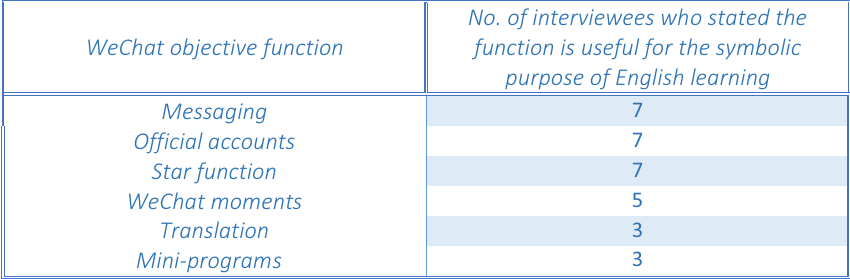
Fig. 4 Objective functions of WeChat that participants use for EFL